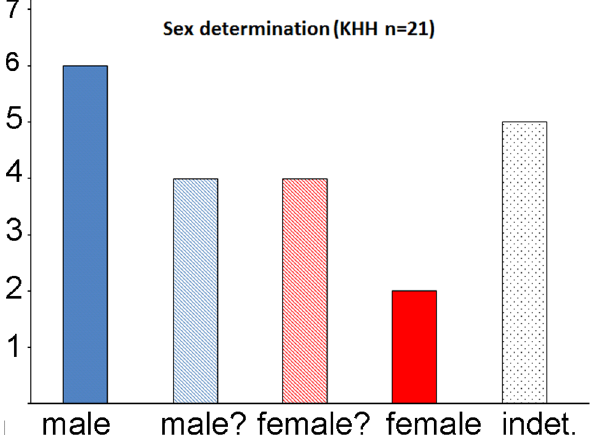
Fig 3. Sex distributions of the investigated individuals. n = absolute numbers (based on data from Eshed et al. [46]; modified after Simmons S1 Table).